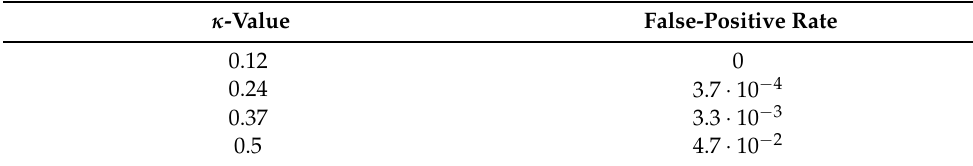
Table 2. False positive rate in an Industrial, Scientific and Medical (ISM) environment.